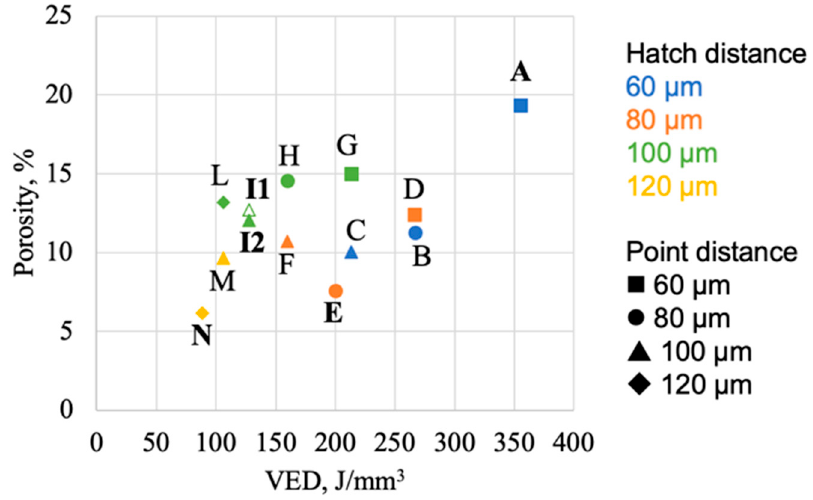
Figure 5. Porosity for each sample as function of VED.